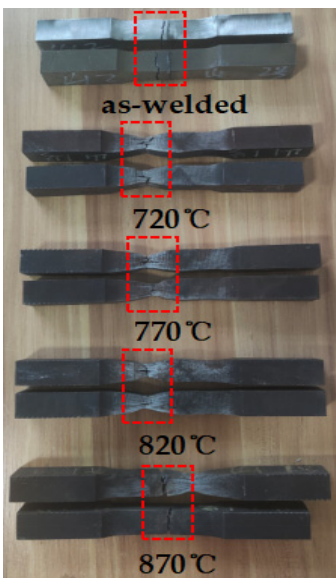
Figure 23. Stretching result diagram.